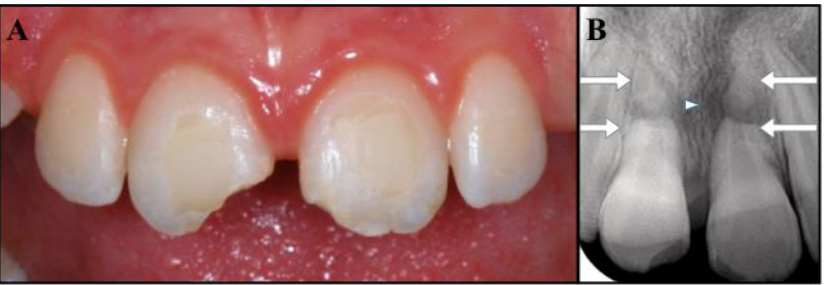
Figure 1. ( A ) Clinical photograph showing the uncomplicated crown fracture of the incisal third of teeth #1.1 and #2.1. ( B ) Periapical radiograph showing the apical root fracture of teeth #1.1 and #2.1 (arrowed) and the radiolucency at the fracture line of #2.1 (small